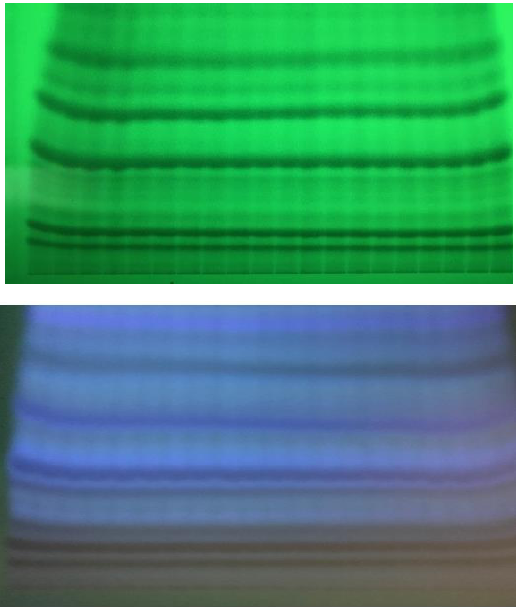
Figure 3. Preparative TLC plates of ethyl acetate fraction eluted in butanol:acetic